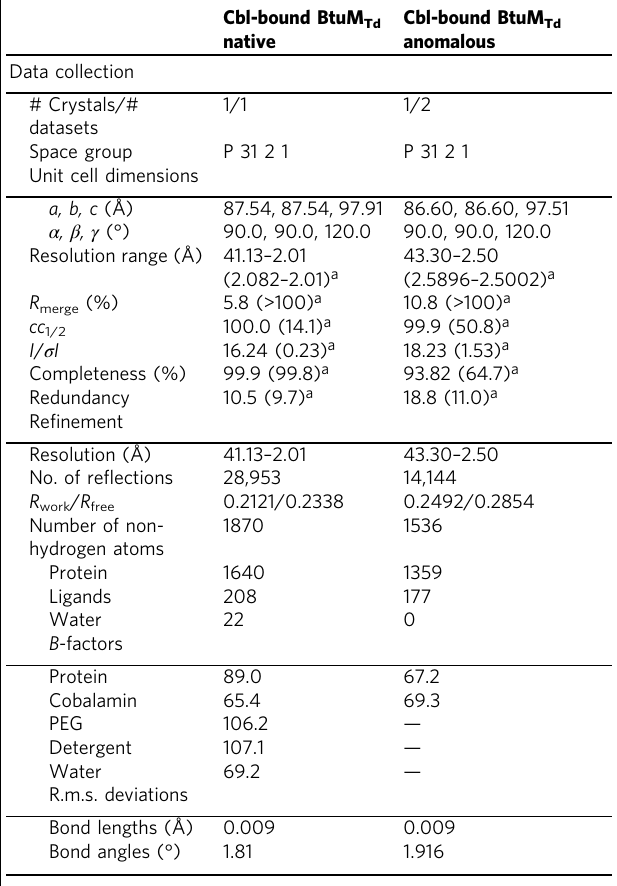
Table 1 Data collection and phasing and re fi